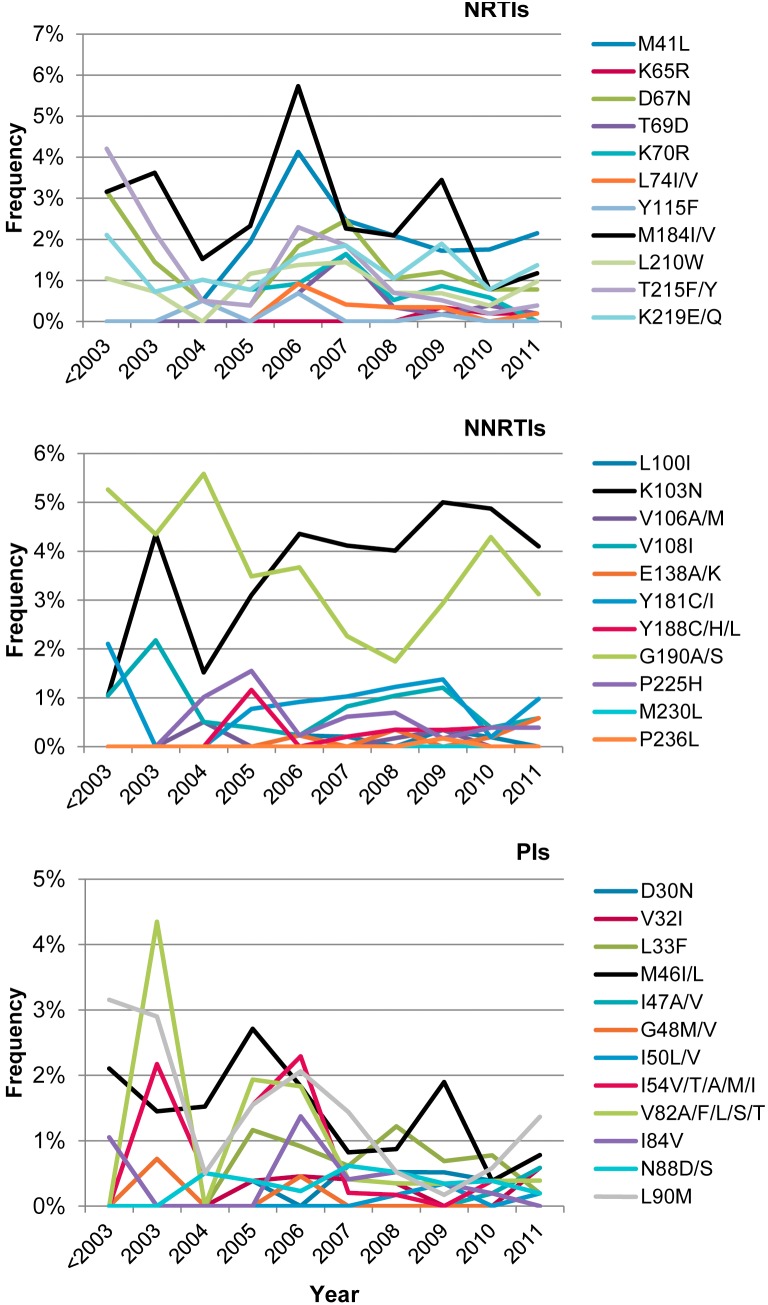
Time trends in frequency of antiretroviral resistance mutations among treatment-naïve patients.Frequency of antiretroviral resistance mutations at selected codons associated with decreased susceptibility to NRTIs, NNRTIs and PIs.